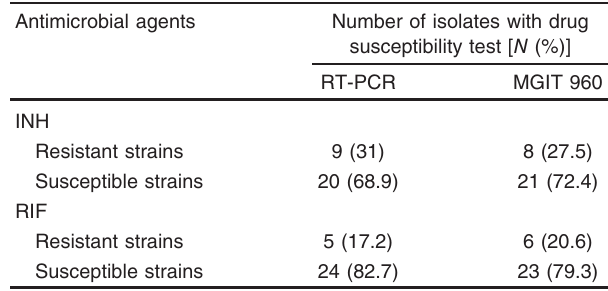
Table 1 Mean time required for isolation of Mycobacterium tuberculosis Sample results